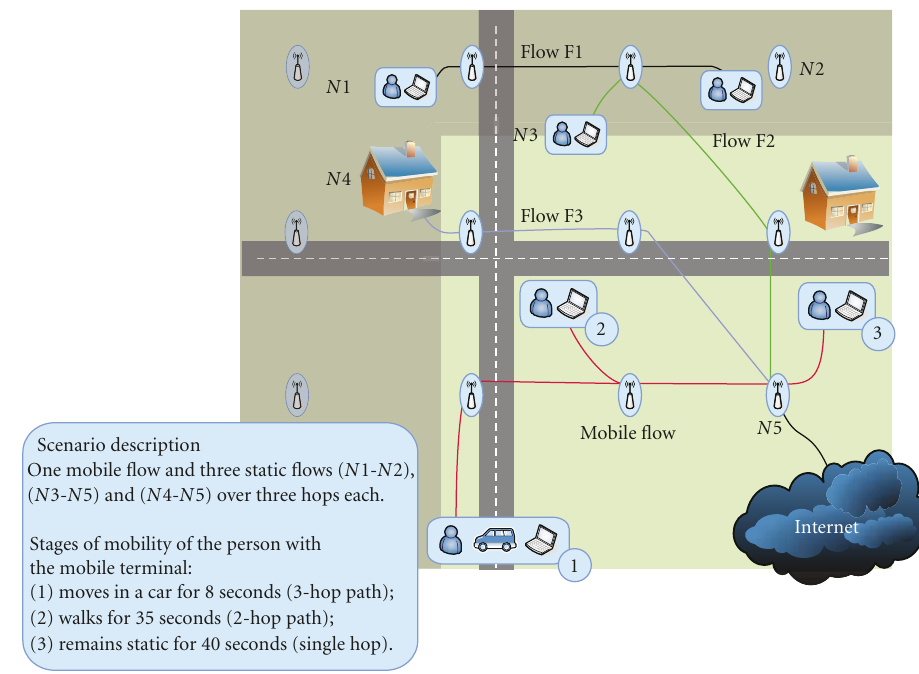
Figure 5: Network setup for the mobility